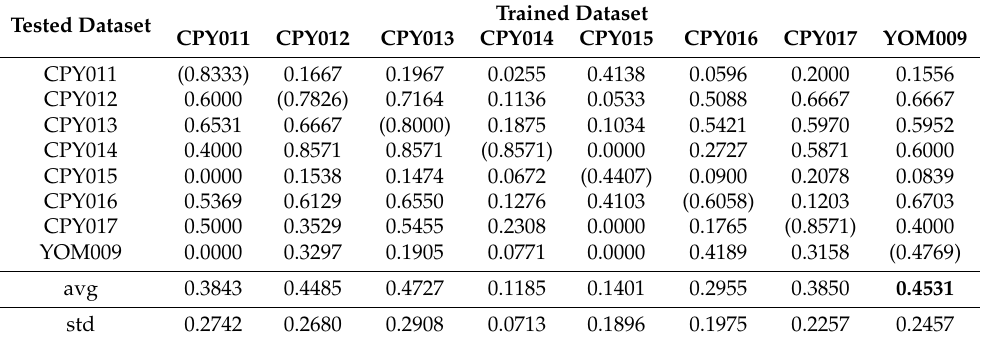
Table 6. The F1-scores of the best DRL models when testing with the dataset from same station (show in the bracket) and different stations, while the average F1-scores and standard deviations of each station were calculated without their own